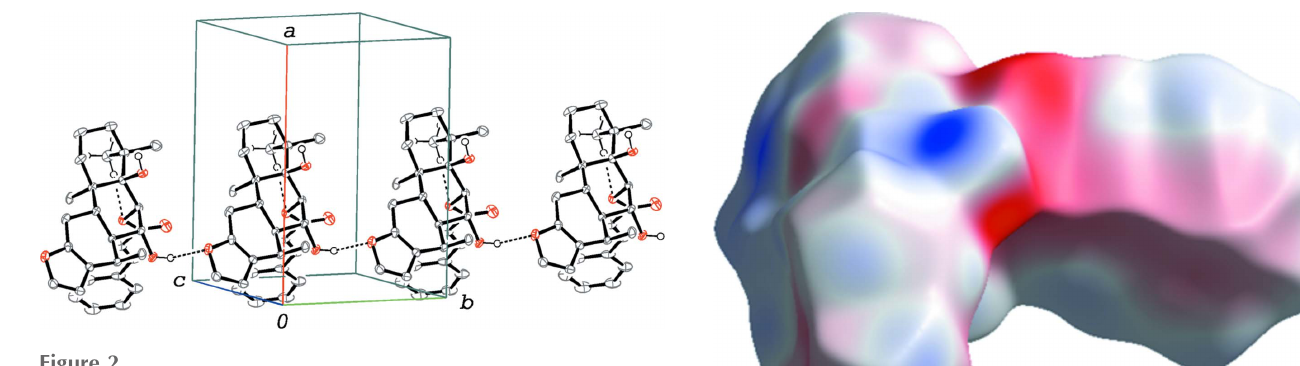
Figure 2 A packing diagram of the title compound. The O—H (cid:2)(cid:2)(cid:2) O and C—H (cid:2)(cid:2)(cid:2) O interactions are shown as dashed lines. H atoms except for the methyl group involved in the C—H (cid:2)(cid:2)(cid:2) O hydrogen bond and the OH groups have been